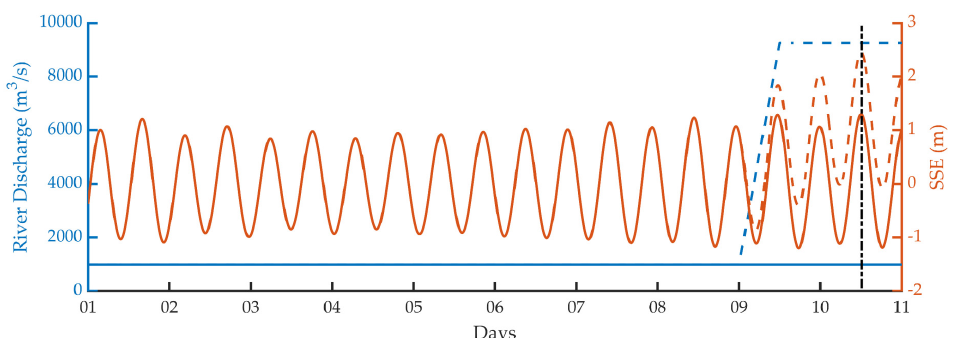
Figure 9. Example of the simulation setup for the Tagus domain showing the historical period under the 100-year return period. Continuous lines represent the reference conditions, while the dashed line considers the 100-year return period conditions for riverine discharge and extreme sea level.